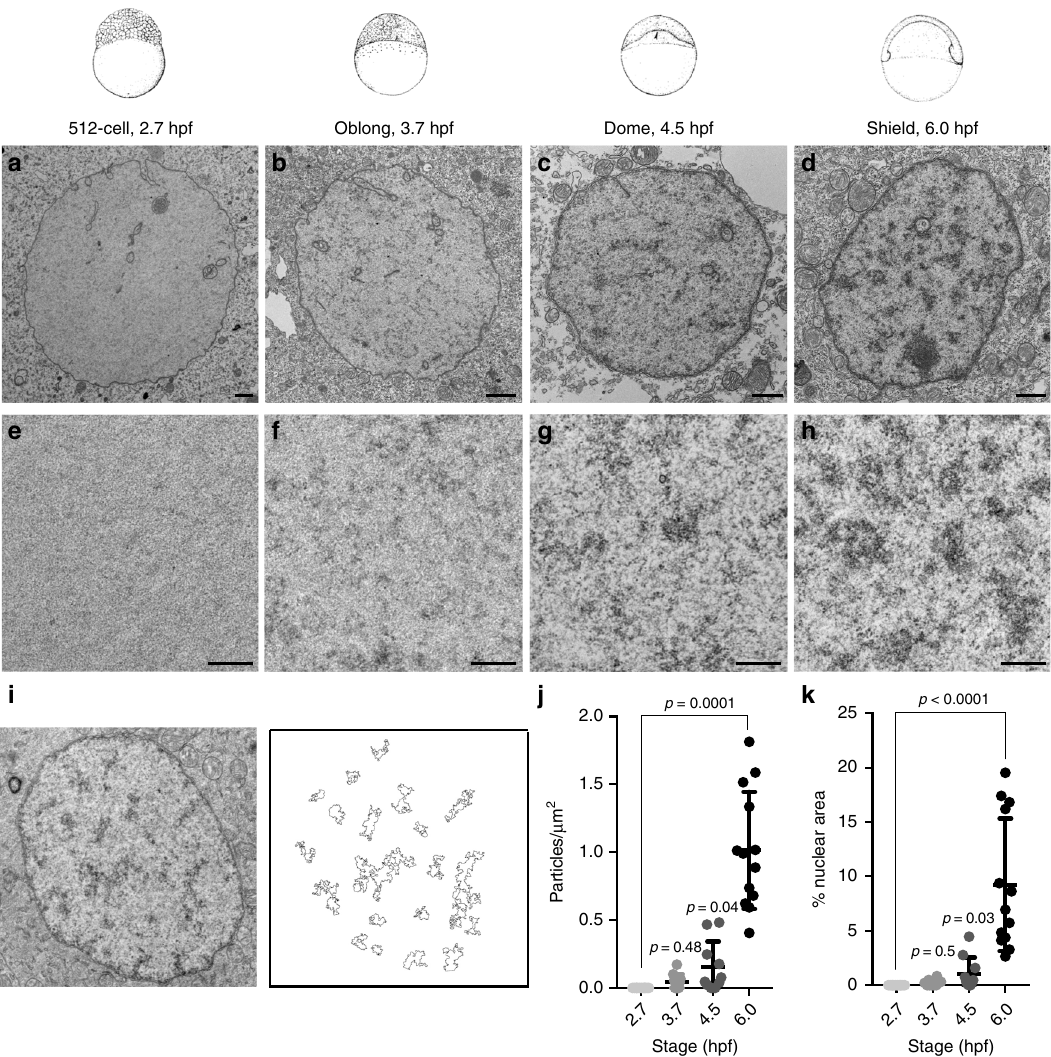
Fig. 2 The early zebra fi sh embryo lacks condensed chromatin ultrastructure. Zebra fi sh embryonic stage schematics are reproduced from Kimmel et al. 22 with permission from John Wiley & Sons Inc. a – h Transmission electron micrographs (TEMs) of representative nuclei from embryos at 2.7, 3.7, 4.5, and 6 h post fertilization (hpf). Images of representative nuclei at speci fi ed time points. e – h Higher magni fi cation images (×20,000) of nuclear interior at speci fi ed time points. All scale bars ( a – h ) indicate 1 μ m. i Representative image illustrating particle selection. j Quanti fi cation of the number of particles per nuclear μ m 2 in TEM images at 2.7, 3.7, 4.5, and 6 hpf. k Quanti fi cation of the percent nuclear area covered by particles in TEM images at 2.7, 3.7, 4.5, and 6 hpf. Nuclei from three embryos were assessed per time point, and electron-dense aggregates were quanti fi ed in four to six representative nuclei from each embryo. Each point represents data from one nucleus. P values were calculated using the Kruskal – Wallis test and corrected for multiple comparisons, error bars indicate standard deviation